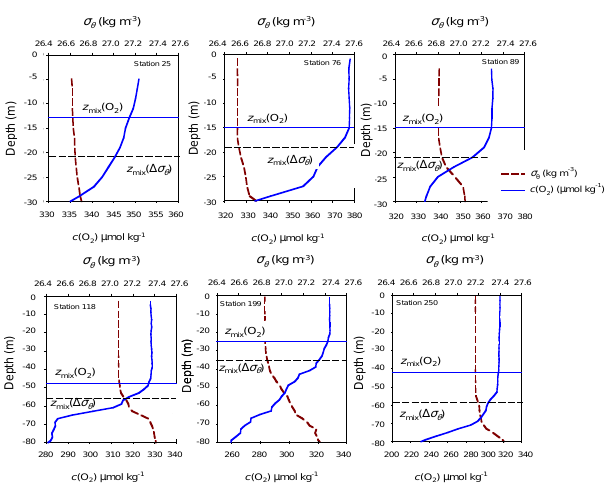
Fig. 2. Vertical profiles of O 2 concentration, c (O 2 ) , and potential density ( σ θ ) . Horizontal lines indicate the location of the objective z mix (O 2 ) and z mix (0.03kgm − 3 ) .